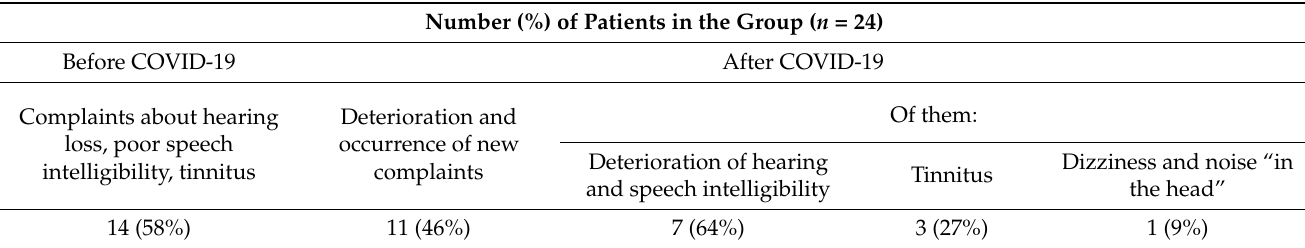
Table 1. Subjective hearing complaints in patients before and after COVID-19. Number (%) of Patients in the Group ( n =